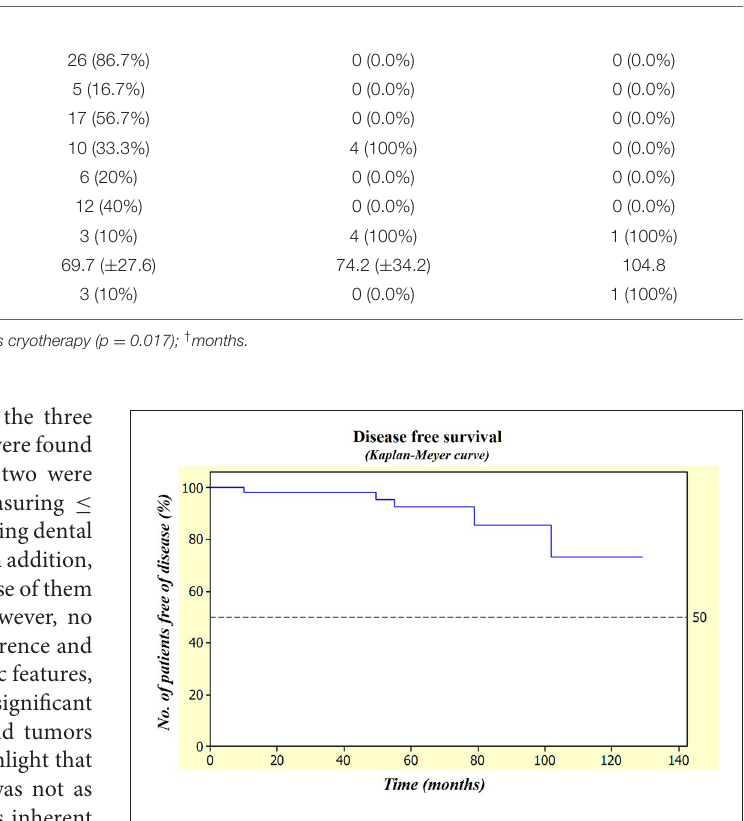
TABLE 2 | Frequency of the post-operative complications, time of follow-up, and incidence of the recurrences according to the therapeutic modality used. Curettage Curettage + Cryotherapy ( n = 18 cases) ( n = 30 cases)